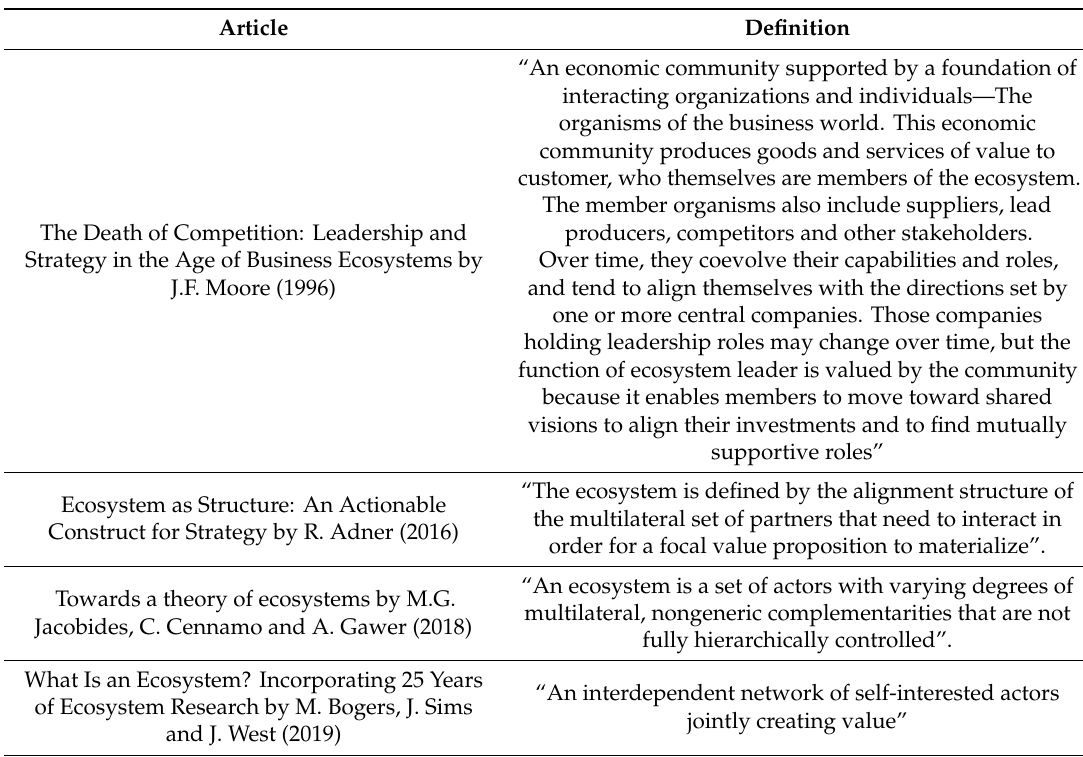
Table 1. Overview of the key BE definitions related to Section